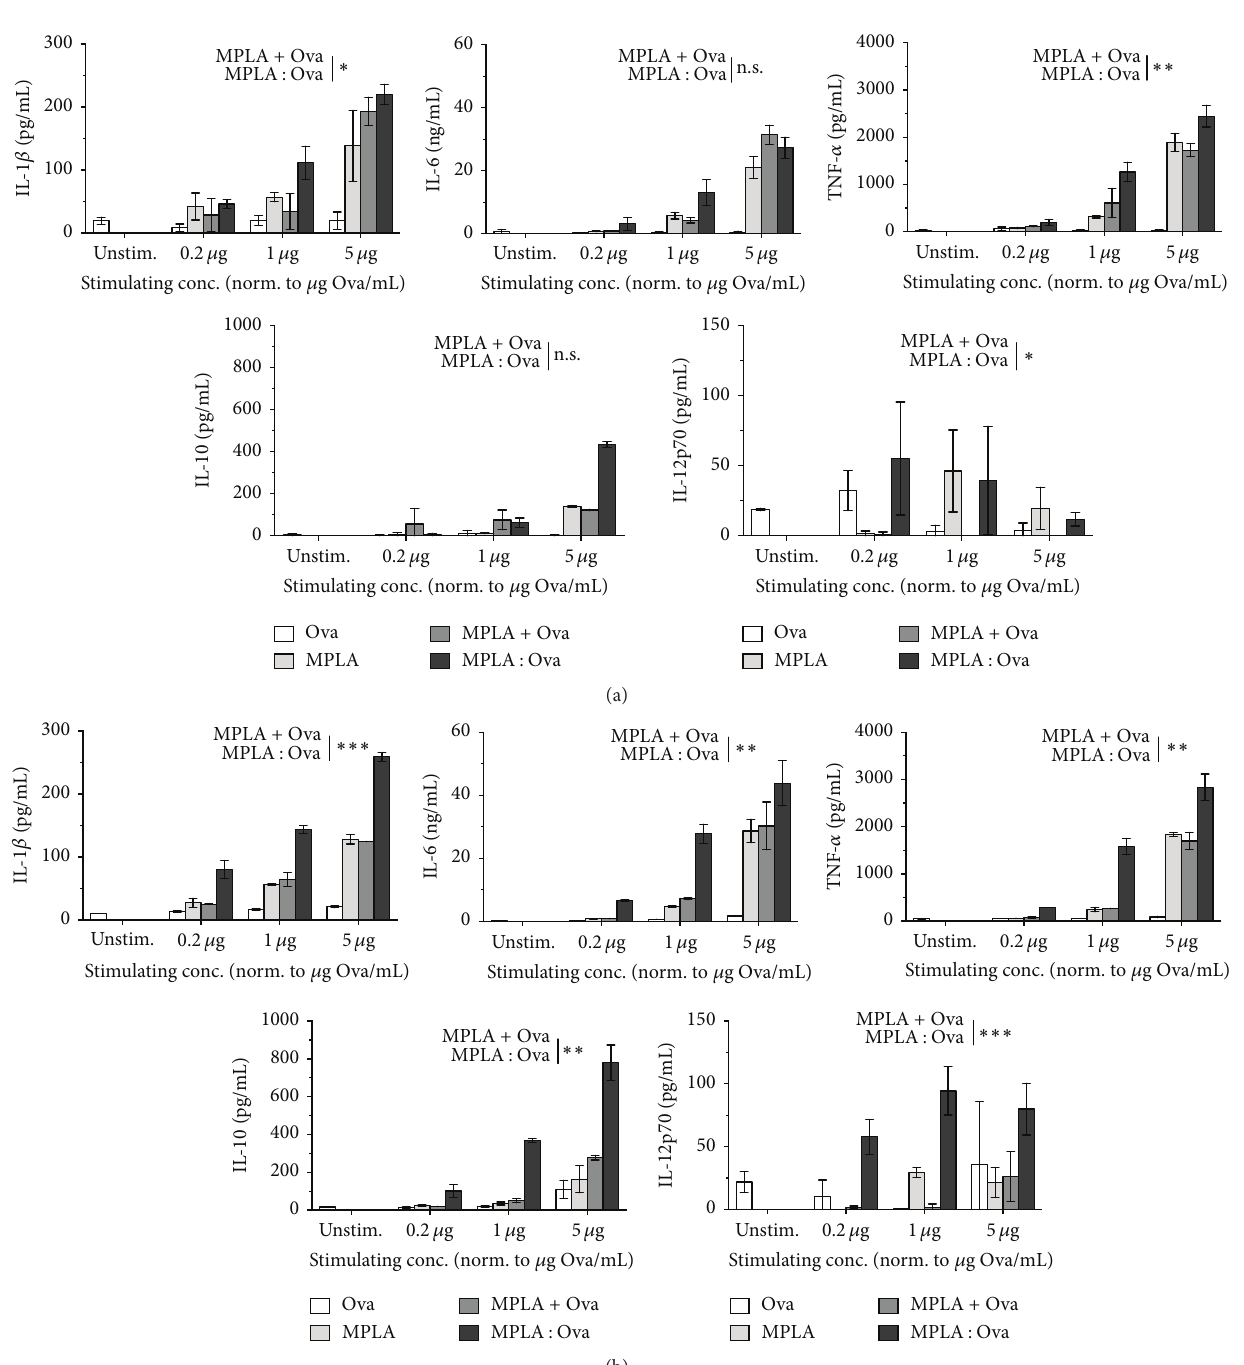
Figure 2: The MPLA: Ova fusion protein boosts mDC-derived cytokine secretion compared to the mixture of both components. Cytokine secretion determined from either BALB/c mDC (3.2 × 10 5 cells/mL, a) or BALB/c mDC (3.2 × 10 5 cells/mL) plus DO11.10 CD4 + T cell (8.0 × 10 5 cells/mL, > 95% purity) cocultures (b) stimulated with equimolar amounts of Ova (white bars), MPLA (light grey bars), MPLA + Ova (dark grey bars), and the MPLA:Ova fusion protein (black bars) for 72 h and analyzed by ELISA. ELISAs were performed using either BD OptEIA (cid:3) ELISA (BD Biosciences) or Ready-SET-Go! ELISA Sets (eBiosciences). Data are mean results of two independent experiments ± SD. The hypothesis of a significant higher cytokine secretion among all three concentrations used for stimulation was tested with a two- factorial analysis of variance (ANOVA) with factors stimulus (0.2, 1.0, and 5.0) and group (“MPLA + OVA” or “MPLA: OVA”). For statistical significant results the following convention was used: ∗ 𝑝 value < 0.05, ∗∗ 𝑝 value < 0.01, and ∗∗∗ 𝑝 value < 0.001. The statistical analysis was performed with SAS (cid:2) /STAT software, version 9.4, SAS System for